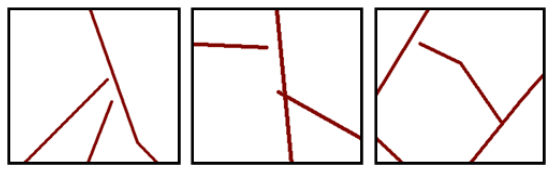
Figure 7: Examples of crossings and errors that was present in the map derived from Douglas-Peucker’s Line Simplification algorithm with a tolerance 0.00024 meters